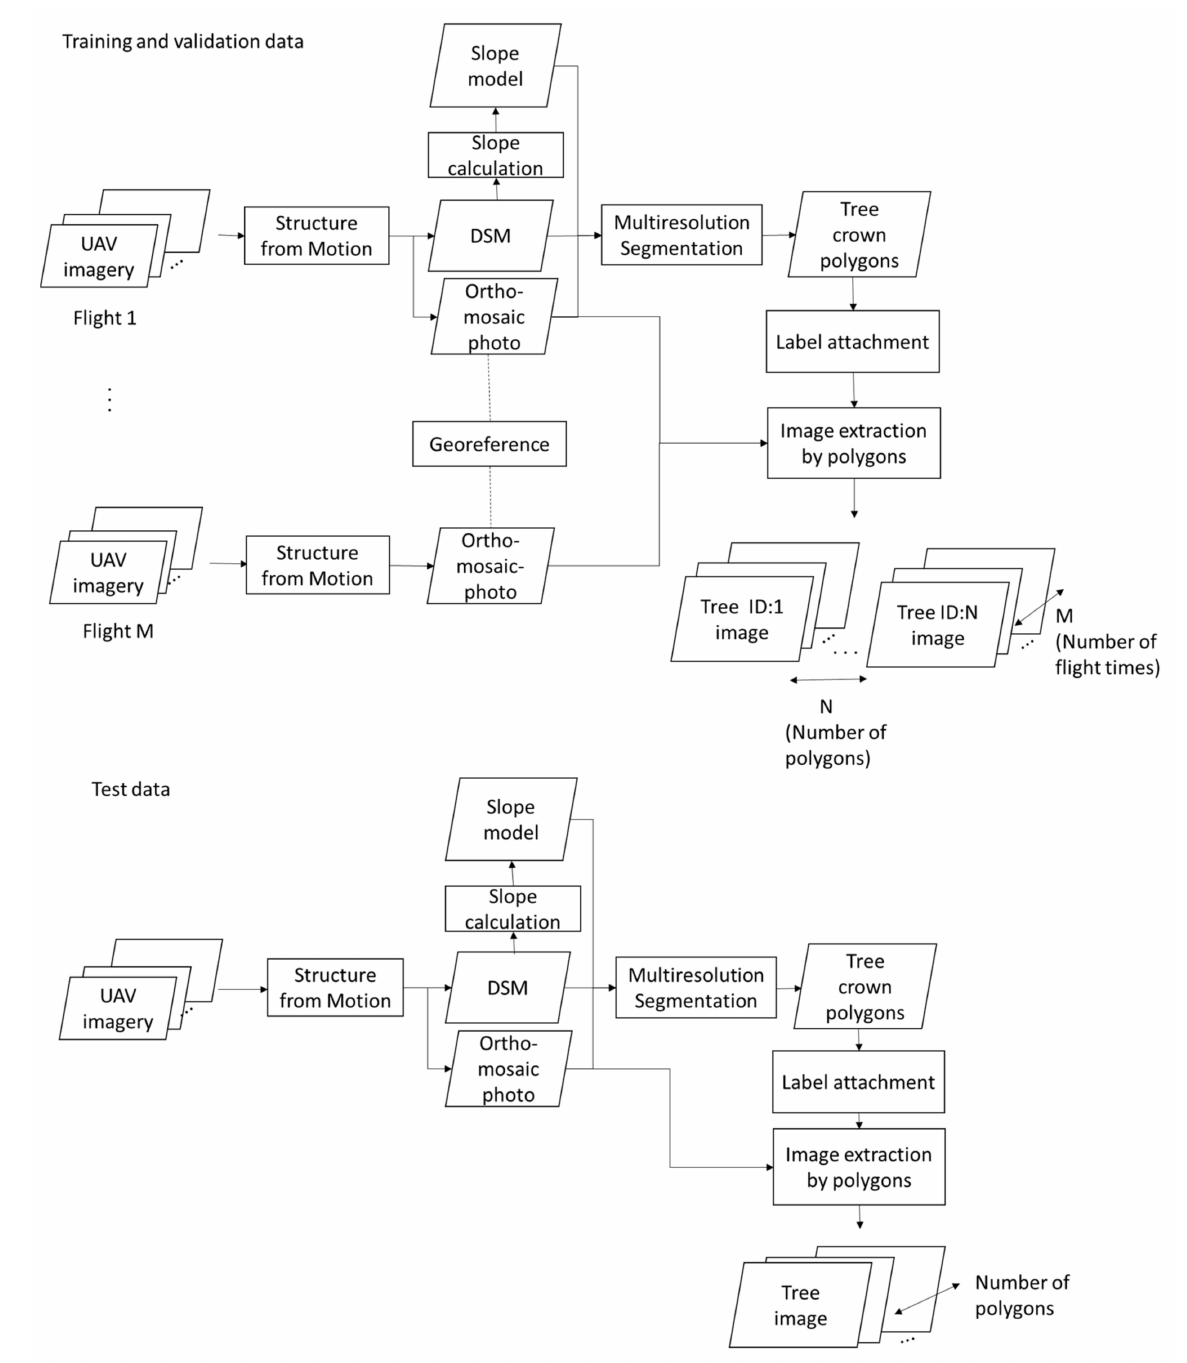
Figure 2. UAV imagery processing workflow. We made tree crown polygons using three-dimensional data and an orthomosaic photo, and extracted individual tree crown images. From this process, in the training dataset, the image of the individual tree is obtained for the number of flights, and the amount of training data is obtained by multiplying the number of flights by the number of polygons. In the test dataset, the flight was conducted only once, thus the amount of test data is the same as the number of tree crown